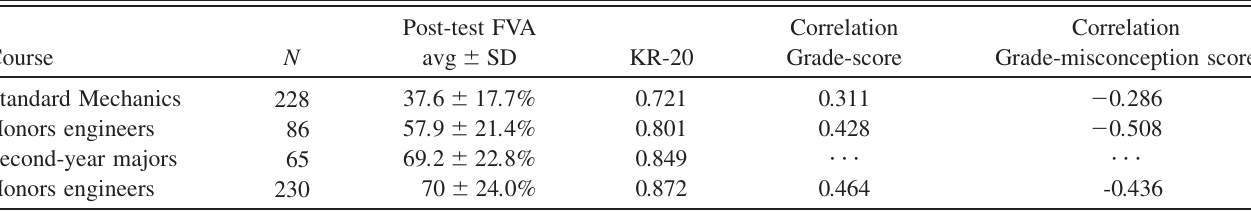
TABLE V. Summary of FVA test